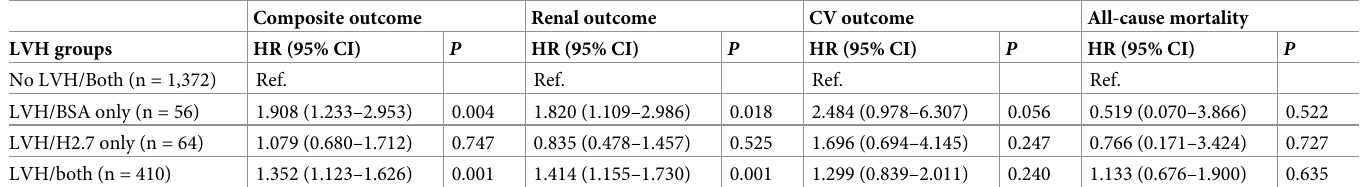
Table 4. Hazard ratio of left ventricular hypertrophy (LVH) groups defined by left ventricular mass index by body surface area or height to the 2.7 power for adverse clinical outcomes. Composite outcome Renal outcome CV outcome All-cause mortality LVH groups Ref. Ref. Ref.